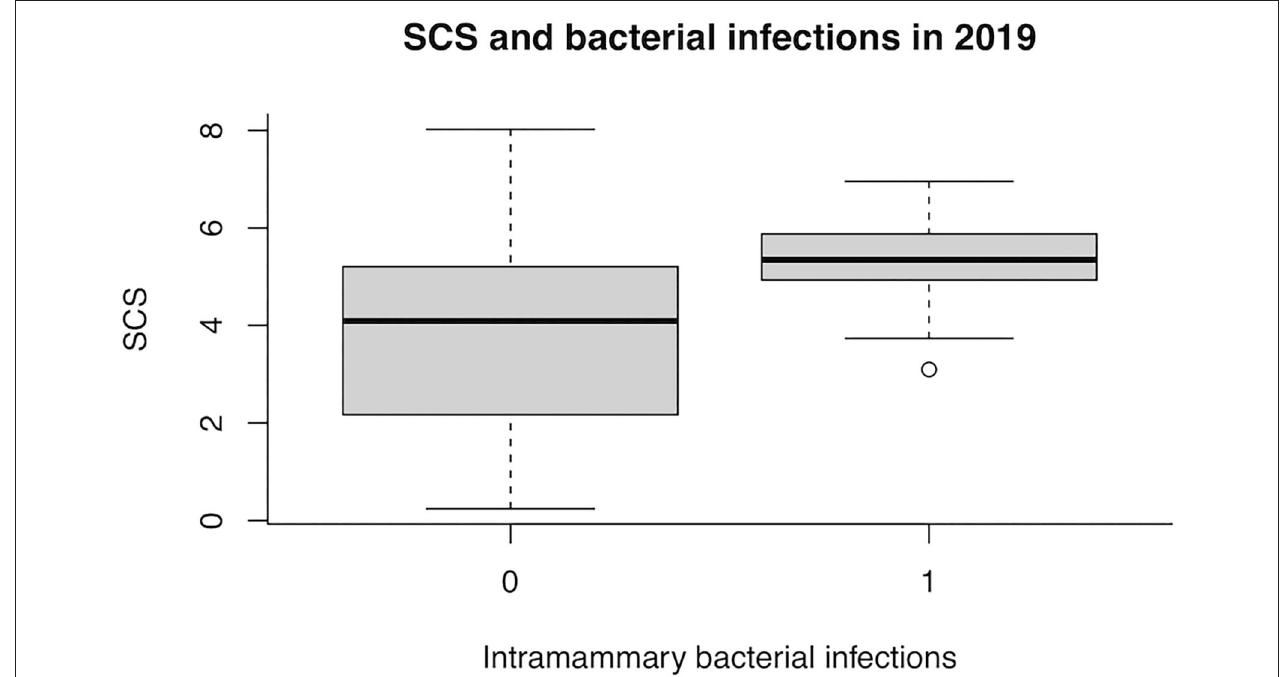
FIGURE 2 | Box plot of somatic cell score (SCS) and bacterial infections in herd A in 2019. 0, no infection; 1, at least one infected teat.